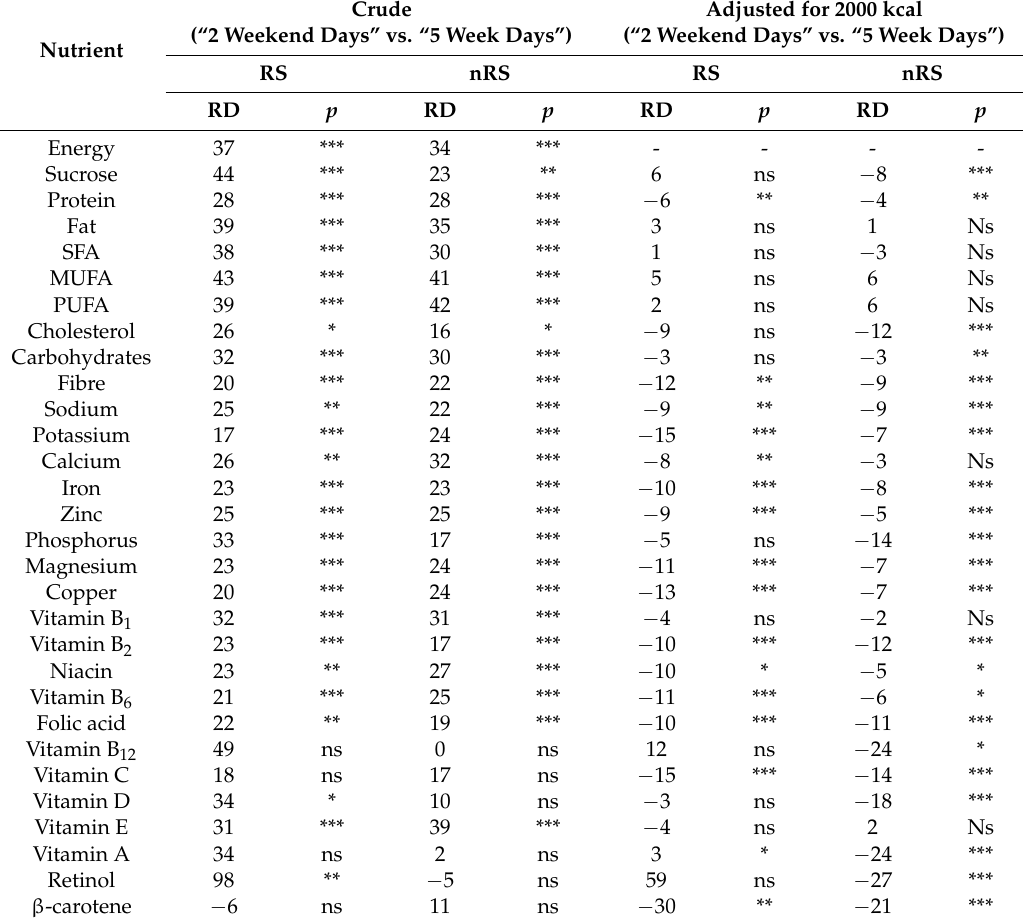
Table 4. Relative differences (RD, in %) in mean daily dietary intakes between weekdays and weekend days in women “restricting sugar” (RS) and “not restricting sugar” (nRS): crude and adjusted for 2000 kcal/day